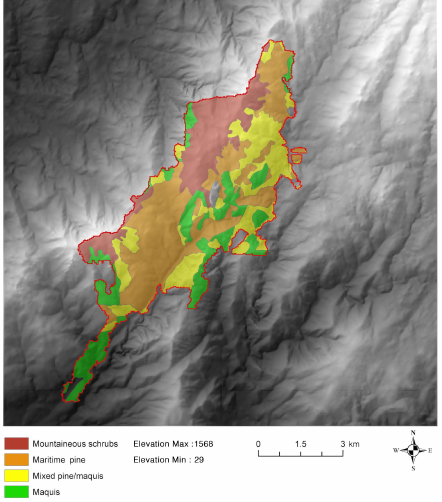
Figure 4. Overview of the fuel distributions with the four main fuel classes over the final observed fire area over elevation in gray